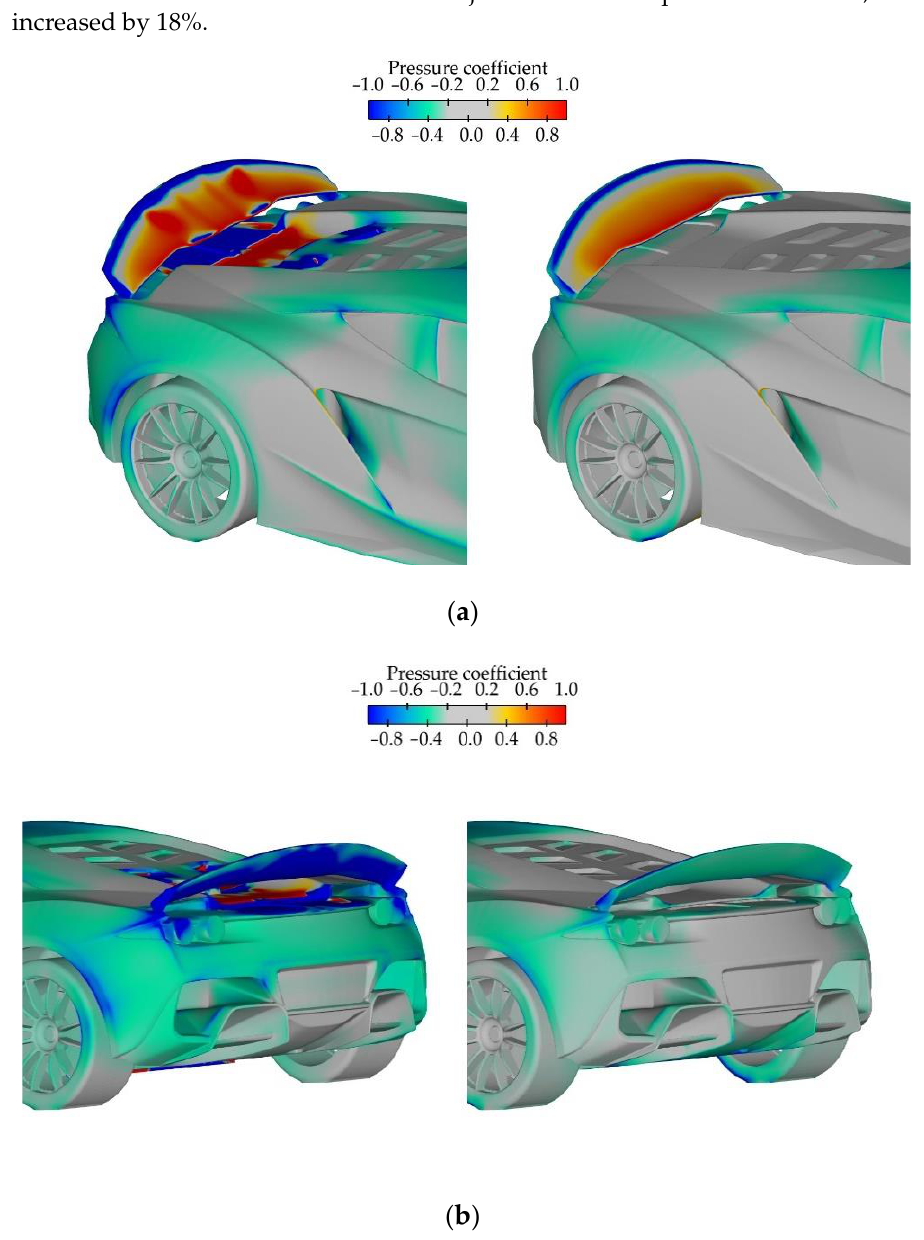
Figure 32. Pressure coefficient for inlet speed of 10 m/s, the case with the FDDG on the left and without FDDG on the right: ( a ) The upper side of the spoiler; ( b ) The lower side of the spoiler.